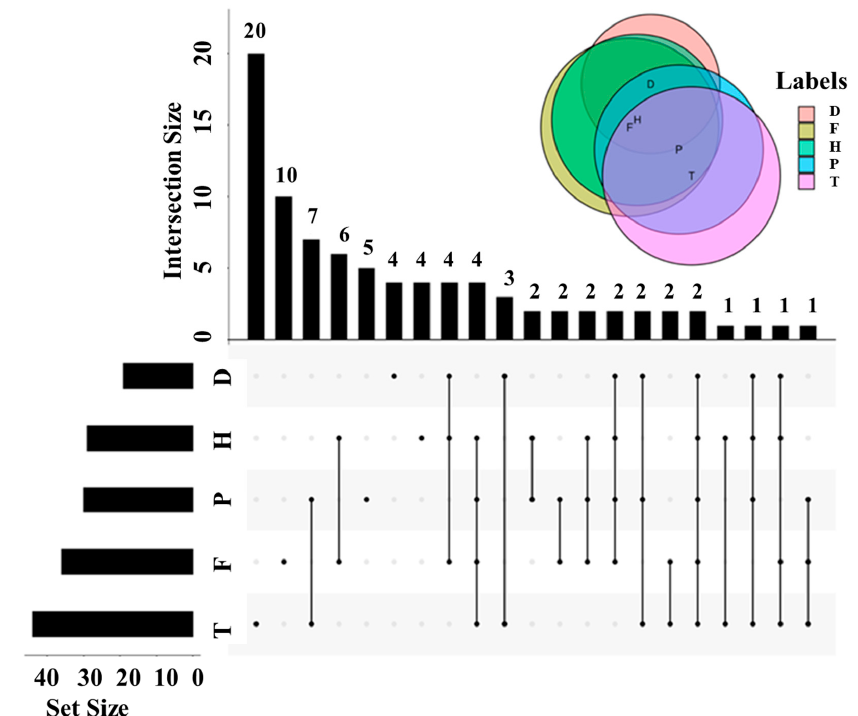
Figure 6. Upset plot of the changed compounds during wine brewing with the treatment of F, H, T, D, and P. Note: F, flutriafol; H, hexaconazole; T, tebuconazole; D, difenoconazole; P, propiconazole. The production of alcohols like ethanol and 2,3-butanediol from sugar degradation by Saccharomyces cerevisiae under anaerobic conditions is a vital process of wine fermenta- tion [48]. In addition to being beneficial to taste, ethanol also had a comprehensive influ- ence on the preservation of wine, and it affects the perception of other aromatic com- pounds [49]. Studies have shown that the increase in sweetness is proportional to the in- creased amount of ethanol, while the bitterness level correspondingly decreases [50]. The content of ethanol was significantly increased after interaction with the P, T, and F groups, indicating that pesticide treatment at an early stage of wine fermentation has a certain effect on sugar and acid metabolism (Figure 5A,C,E) [51,52]. 2,3-butanediol was the sec- ond largest byproduct of alcohol fermentation, which affects the aroma and body of wine due to its bitterness and viscosity [53]. In the T and F groups, the reduced 2,3-butanediol content reflected that the pesticides induce a reduced bitterness and viscosity in the wine (Figure 5A,C). In addition, they reduce the fermentation activity of Saccharomyces cere- visiae , thereby affecting the synthesis of volatile compounds in other metabolic pathways.